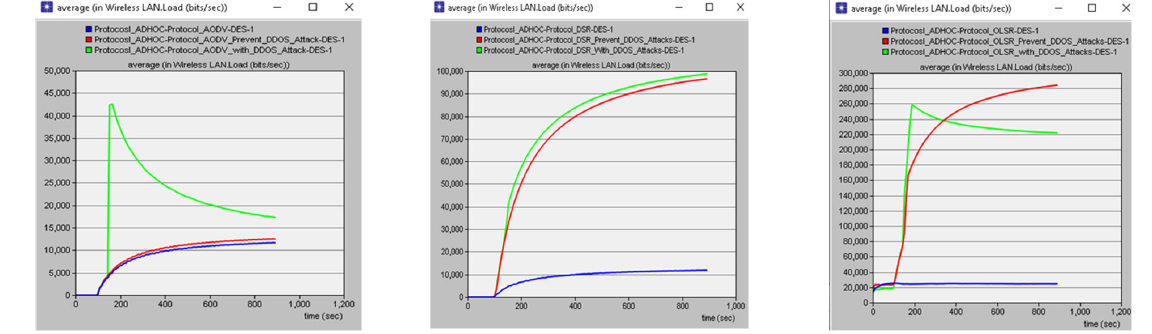
Fig. 6. Load for each protocol in different scenarios